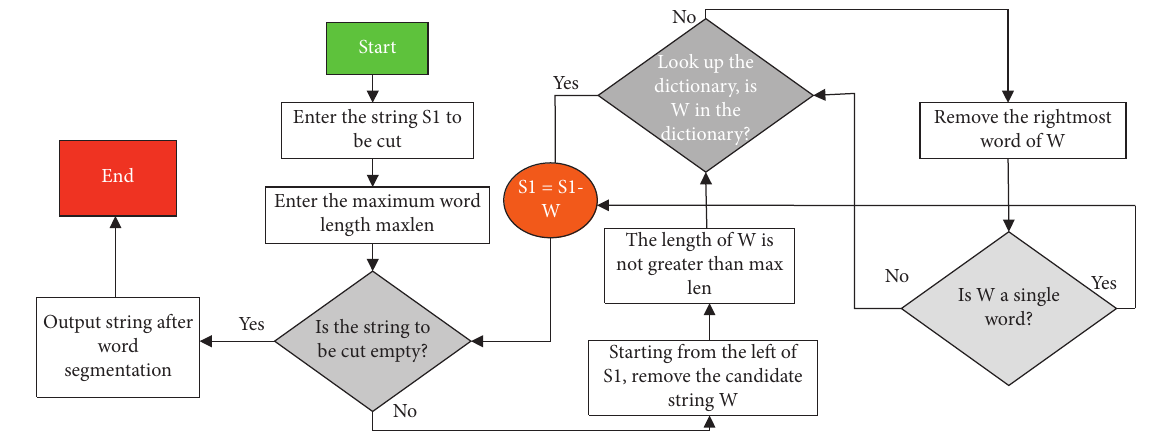
Figure 3: Maximum forward